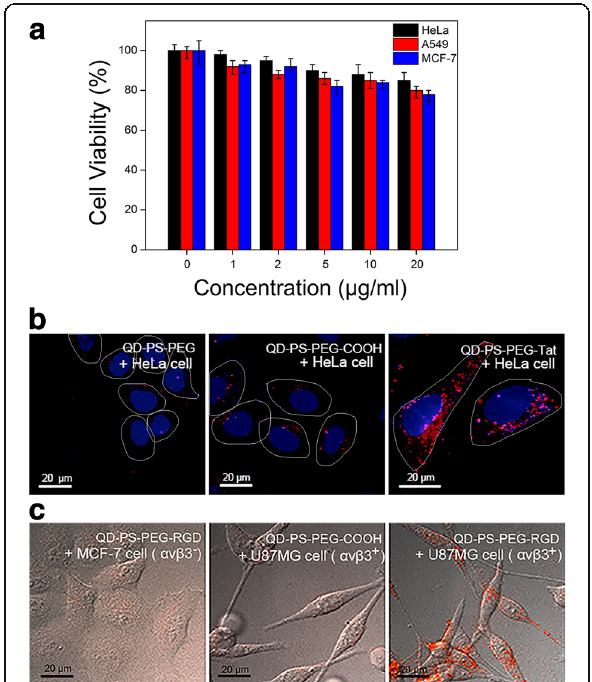
Fig. 6 Interactions of PS-PEG micellar QDs (prepared by using sonication 30 s in the interfacial instability method) with biological cells. a PS-PEG micellar QDs were fairly biocompatible judging from the MTT cytotoxicity assay results. The concentrations were based on the amounts of QDs used. b Tat peptide-conjugated PS-PEG micellar QDs can be internalized by live cells. c RGD peptide-conjugated PS- PEG micellar QDs can specifically recognize and bind with the α β v 3 -integrin molecules over-expressed on U87MG cells ( right image ). In comparison, in the absence of α v β 3 -integrin over-expression (MCF-7 cells, left image ) or Tat peptide (PS-PEG-COOH micellar QDs, middle image ), no significant binding (QD fluorescence) was observed. The red fluorescence was from QDs. The cell nucleus was stained by the blue fluorescent dye Hoechst 33342. Cell periphery is shown by white line (from the corresponding bright field microscopy